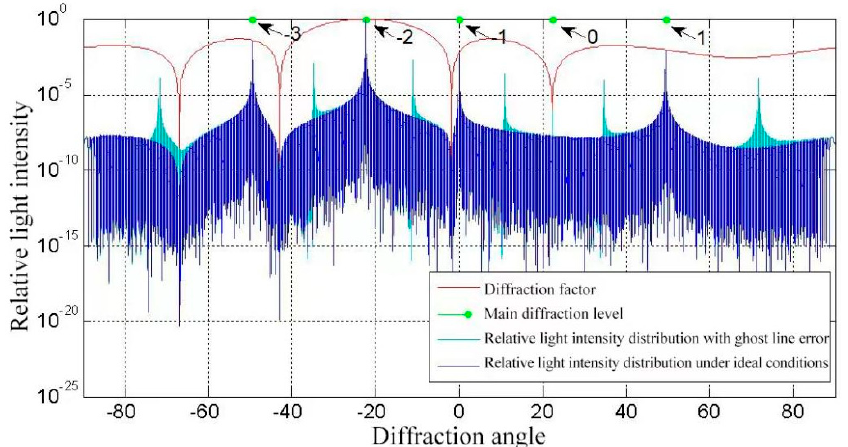
Figure 5. The relative intensity distribution of diffracted light.